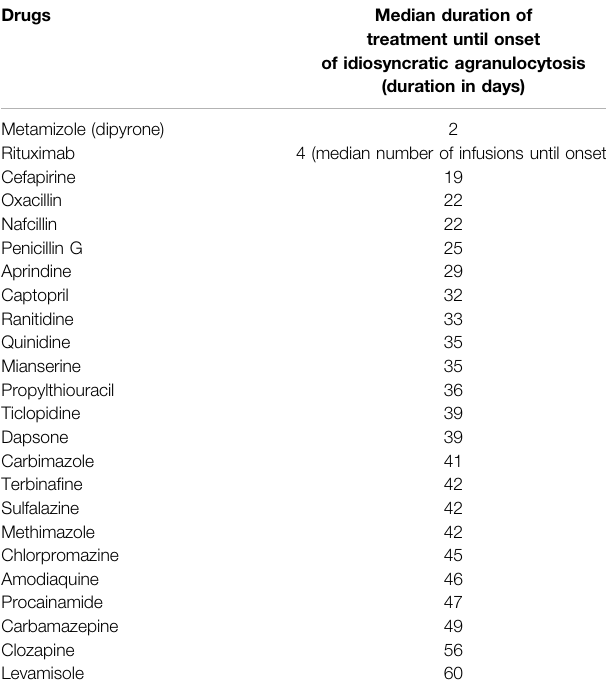
TABLE 2 | Median treatment time until the occurrence of idiosyncratic agranulocytosis; adapted from (Andersohn et al., 2007).